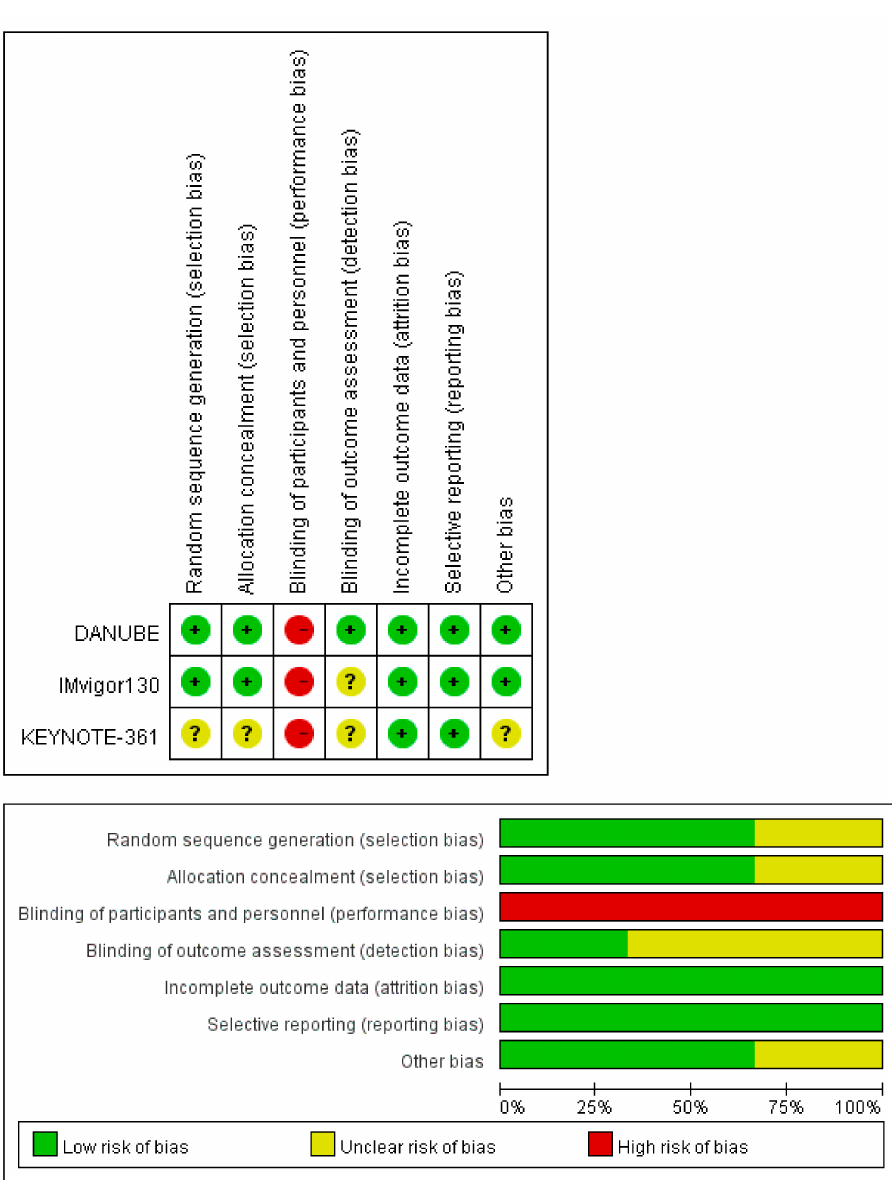
Figure A1. Quality assessment by the risk of bias (ROB)